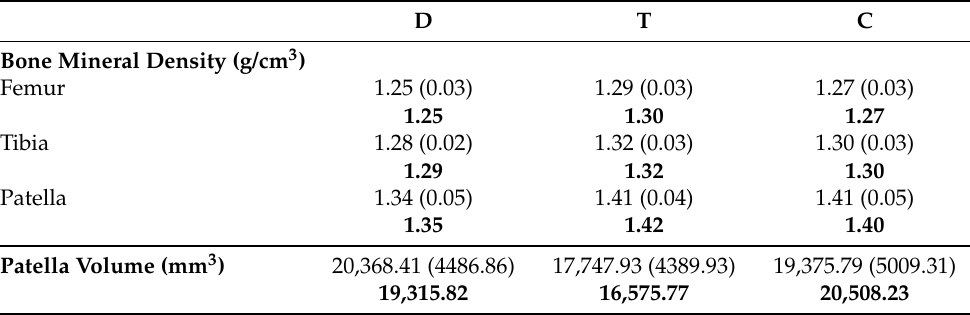
Table 1. The 3D results. Mean is reported for each group. Standard deviation is reported in brackets and median in the row below in